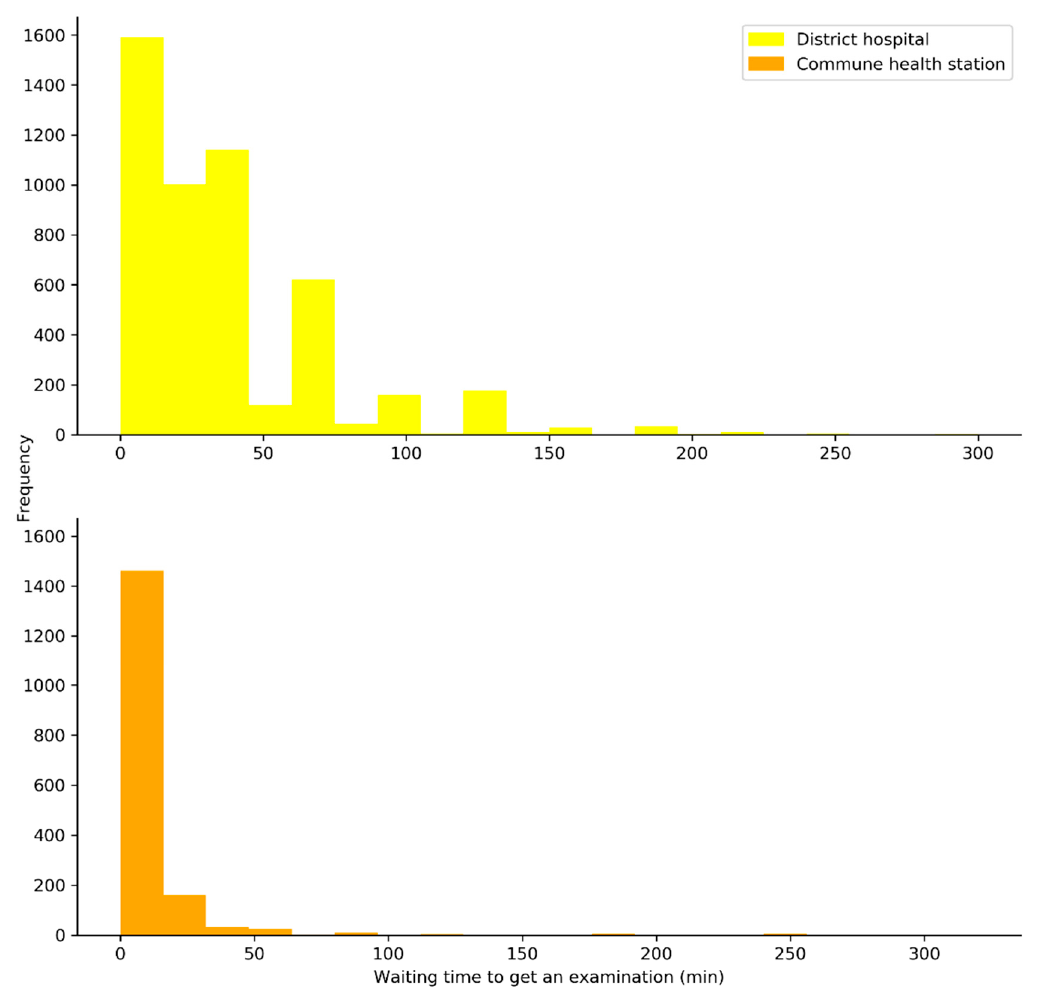
Figure 2. Distribution of the outpatient waiting times in district hospitals (DHs) and commune health centers (CHCs).